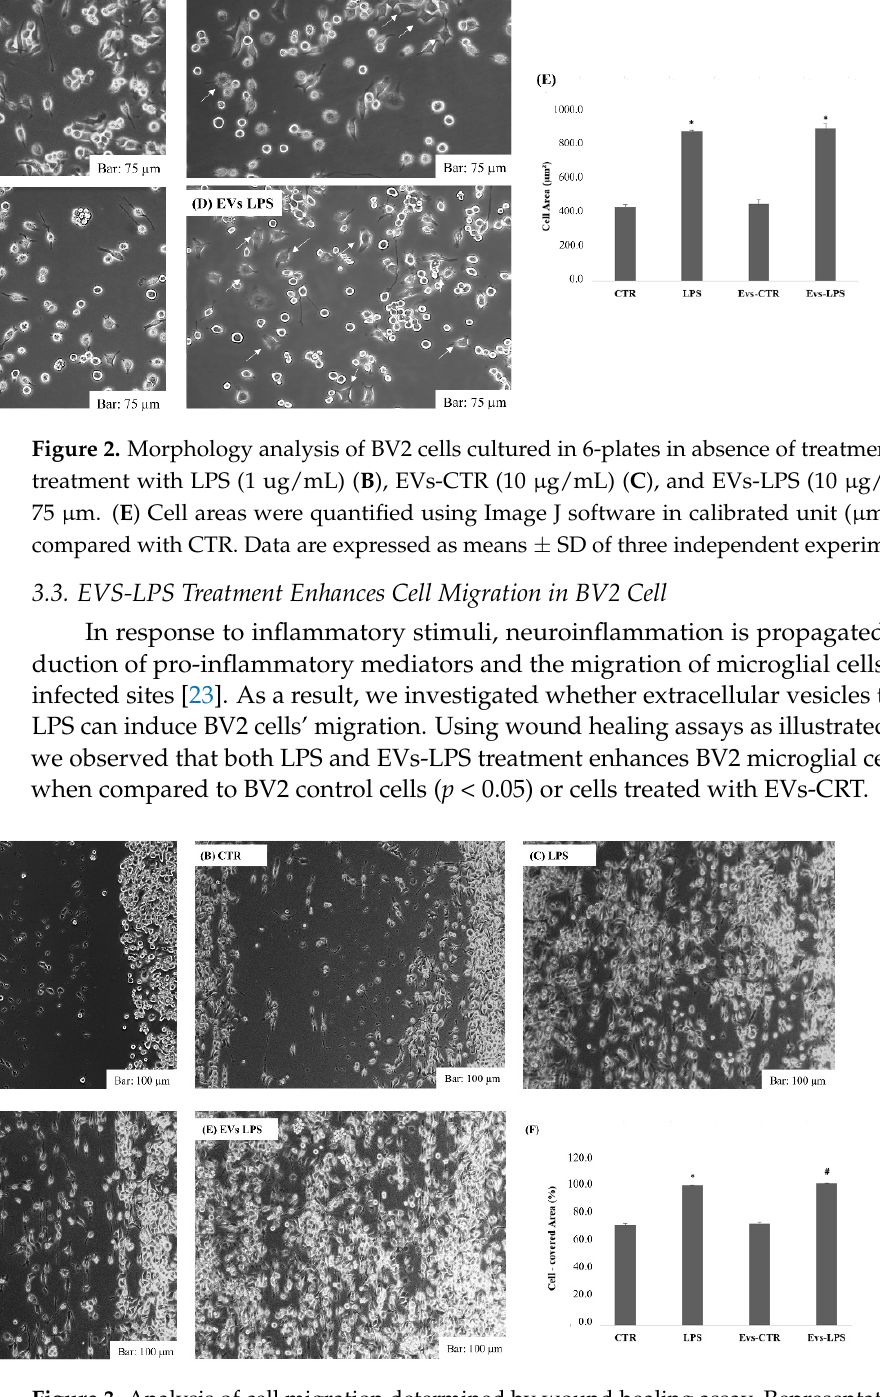
Figure 3. Analysis of cell migration determined by wound healing assay. Representative images of wound healing assay at time 0 ( A ), after 24 h in control cells ( B ), cell stimulated with LPS (1 ug/mL) ( C ), or with EVs-CTR (10 μ g/mL) ( D ) or EVs-LPS (10 μ g/mL) ( E ). Bar 100 μ m. ( F ) Cell areas were quantified using Image J software. Data are presented as the mean ± SD of triplicate experiments. (* p -value < 0.05 compared to control cells; # p -value < 0.05 compared to